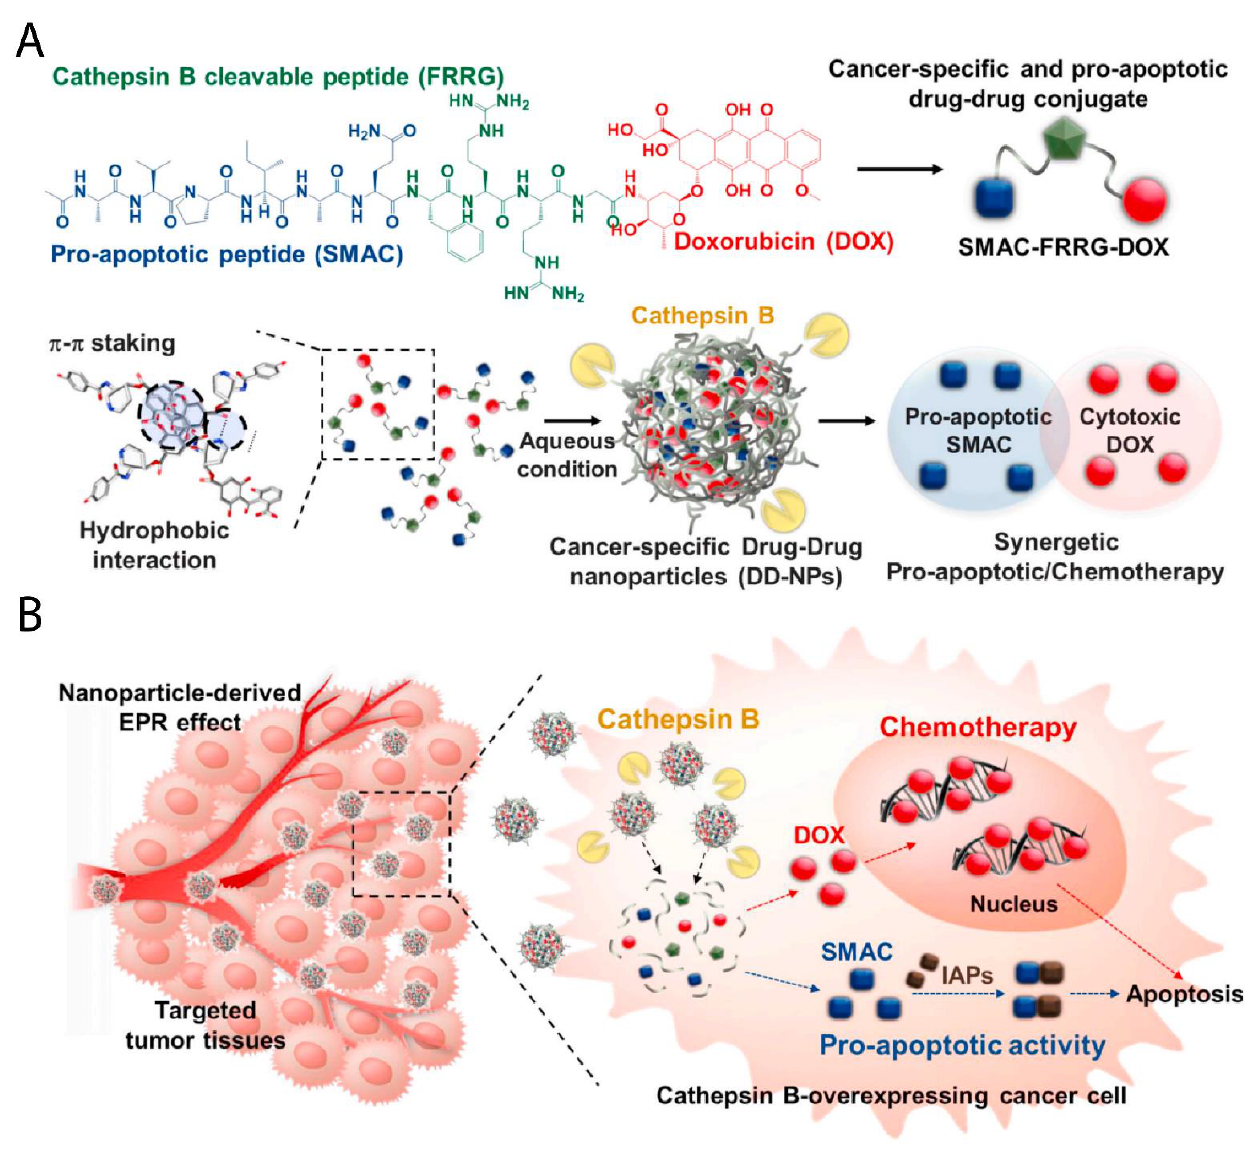
Figure 6. Schematic illustration of DD-NP structure and mechanism of action. ( A ) Molecular and schematic structure of DD-NPs. ( B ) DD-NPs accumulate in tumor tissue through the enhanced permeability and retention effect (EPR). Cathepsin B then cleaves the drug – drug interactions to release DOX and SMAC into the cancer cells. Reproduced with permission from Refs [84].